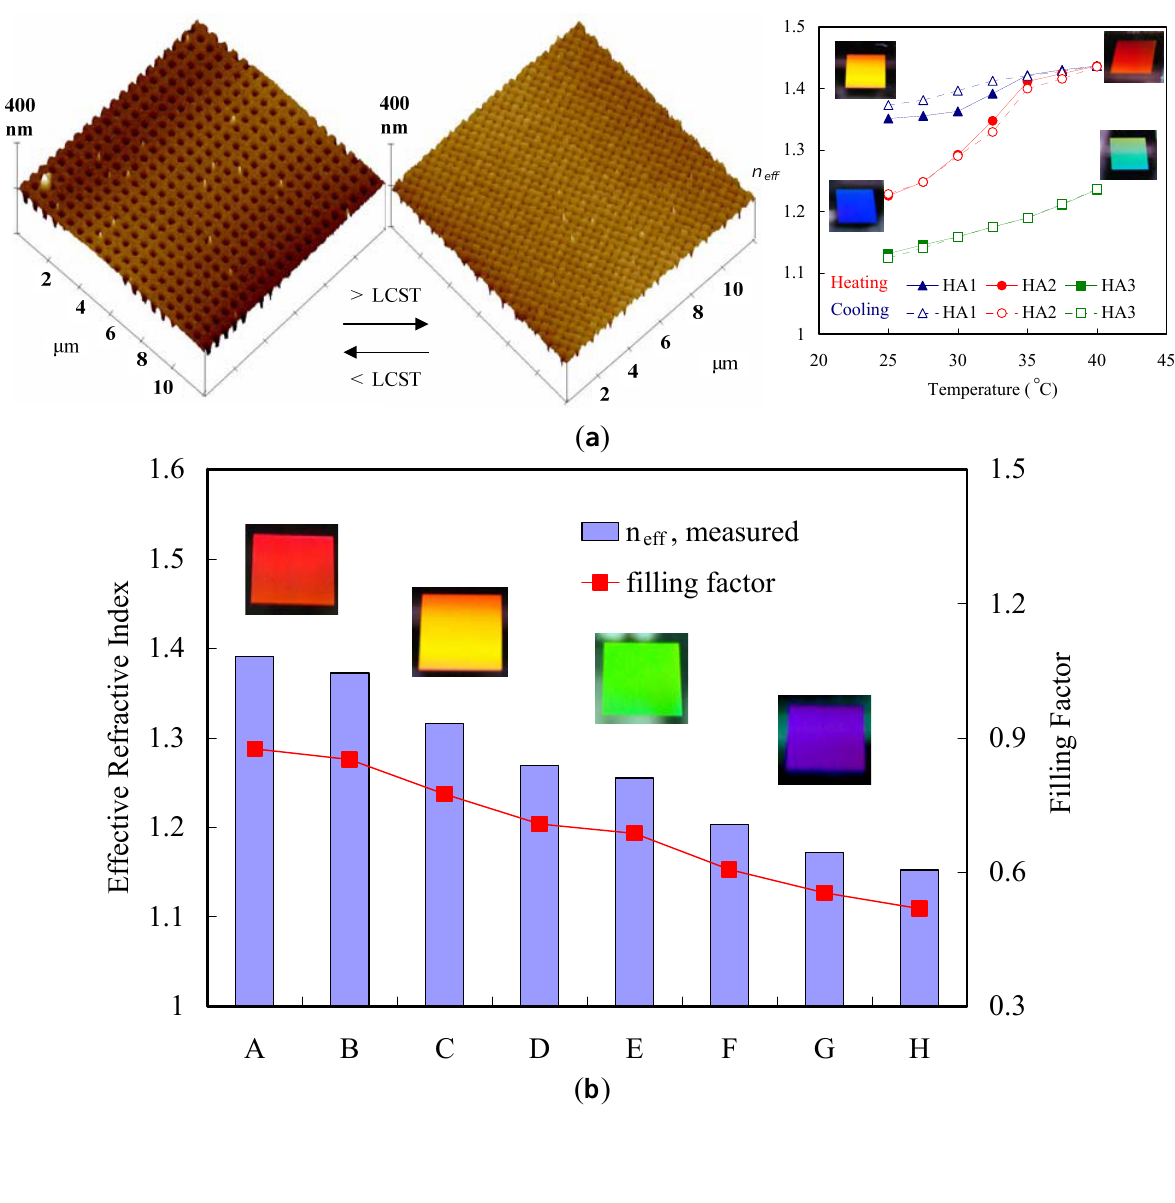
Figure 20. ( a ) Geometrical parameters and/or refractive index contrast of a 2DPCG typically change with the temperature resulting color change [238]; ( b ) neff response and calculated filling factor of 2DPRG of tethered PMMA layer as a function of solvent species for volatile organic compounds (VOC) exposing in the order of chloroform (A); 1,2-dichloroethane (DCE) (B); dioxane (C); toluene (D); tetrahydrofuran (THF) (E); cyclohexane (F); acetone (G); and in dry state (H). Photographic images demonstrate the grating effect of the 2DPRG under VOC exposing of chloroform, dioxane, THF, and acetone, from left to right. Reprinted from Reference [239] with